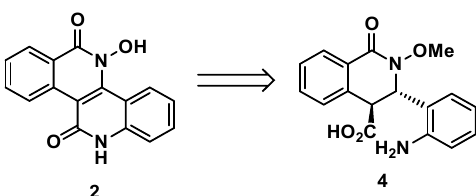
Figure 3. Retrosynthetic analysis N -hydroxy dibenzo[ c,h ][1,6]naphthyridine 2.